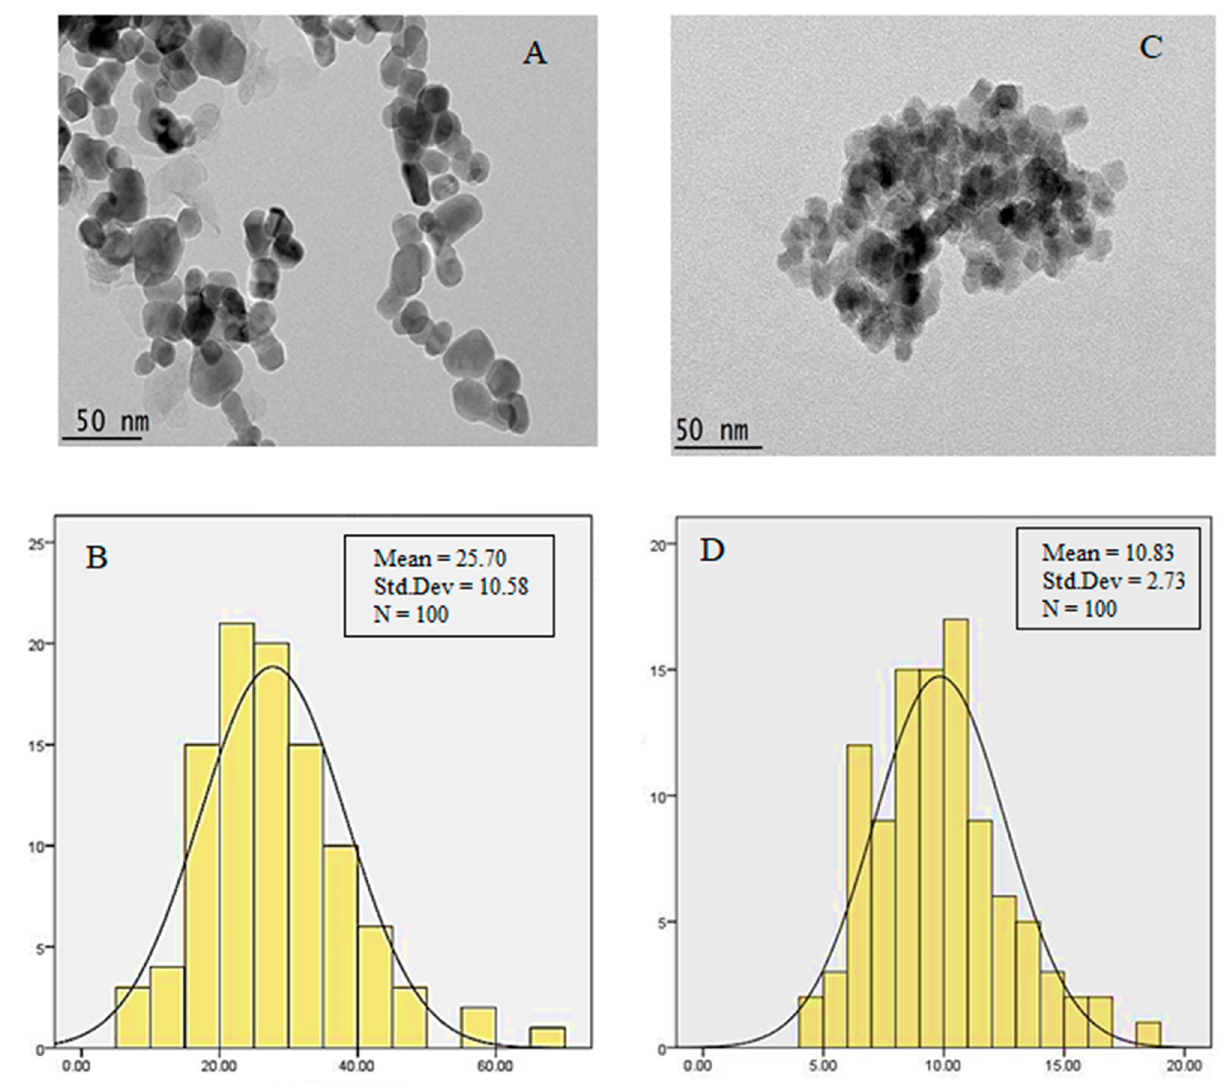
Figure 5. TEM micrographs of the synthesized powders ( A ) Fe 3 O 4 @-PEG-SFB; ( B ) their particle size distribution; ( C ) Fe 3 O 4 nanoparticles; ( D ) their particle size